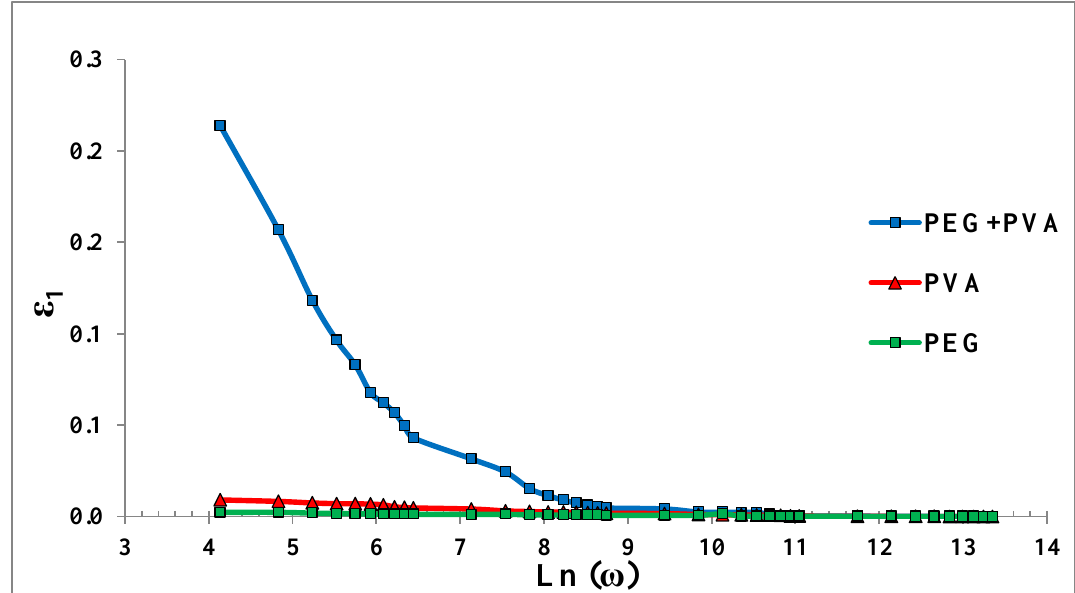
Fig. 3A: The variation of the dielectric constant with frequency for PVA, PEG and PVA+PEG composites.